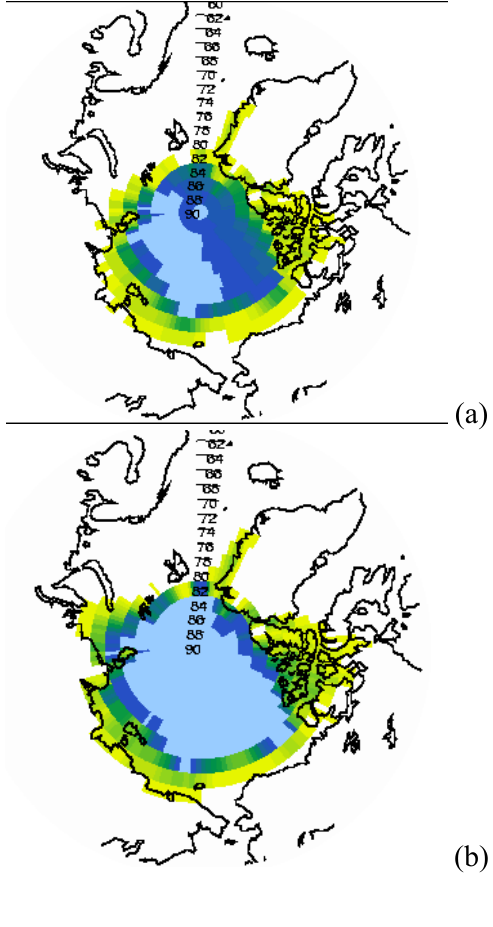
Figure 6. Fraction of surface area covered by sea ice near the North Pole from climate simulations with increasing density of high-altitude devices throughout the atmosphere: